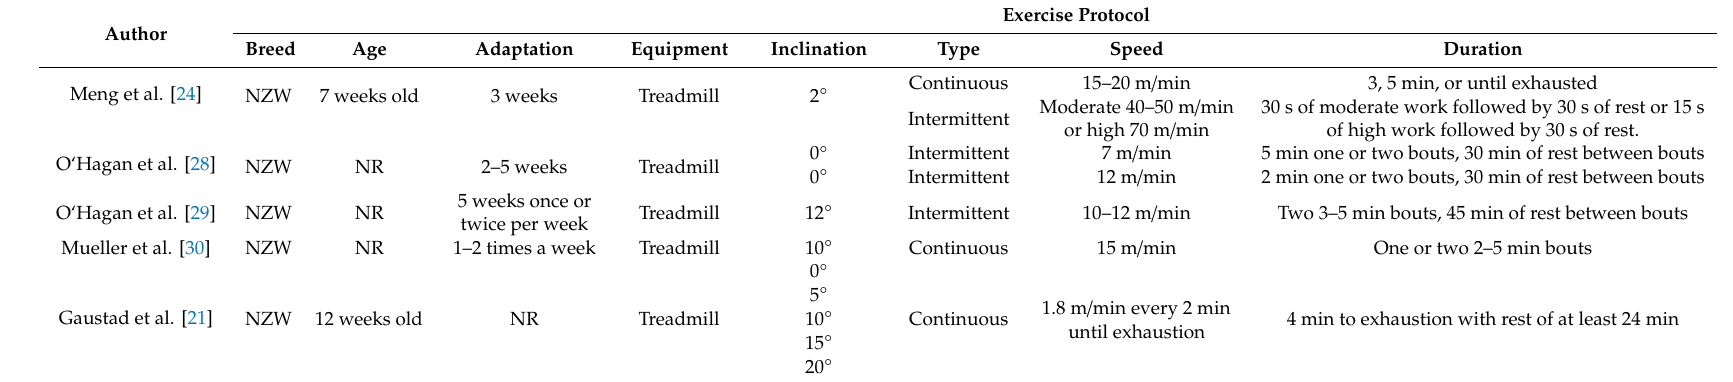
Table 1. Protocols for acute exercise in